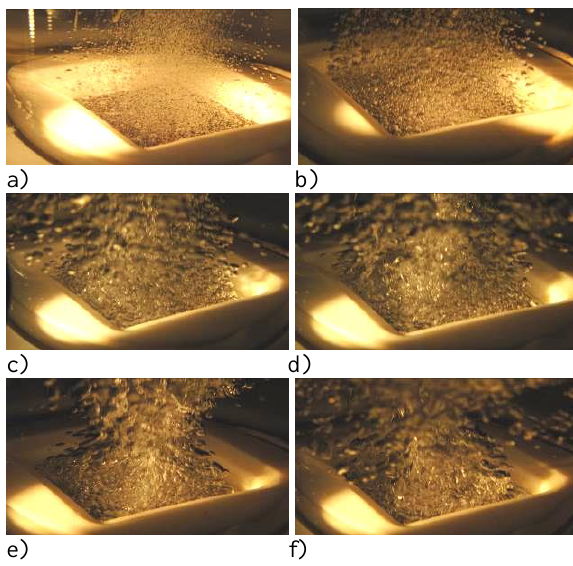
Fig. 6. Visualization of pool boiling with Novec-649 on the microchannel surface MC-0.2-0.2-0.4, a) q = 3.3 W/m 2 , b) q = 7.3 kW/m 2 , c) q = 12.9 kW/m 2 , d) q = 19.5 kW/m 2 , e) q = 26.5 kW/m 2 , f) q = 43.2 kW/m 2 .